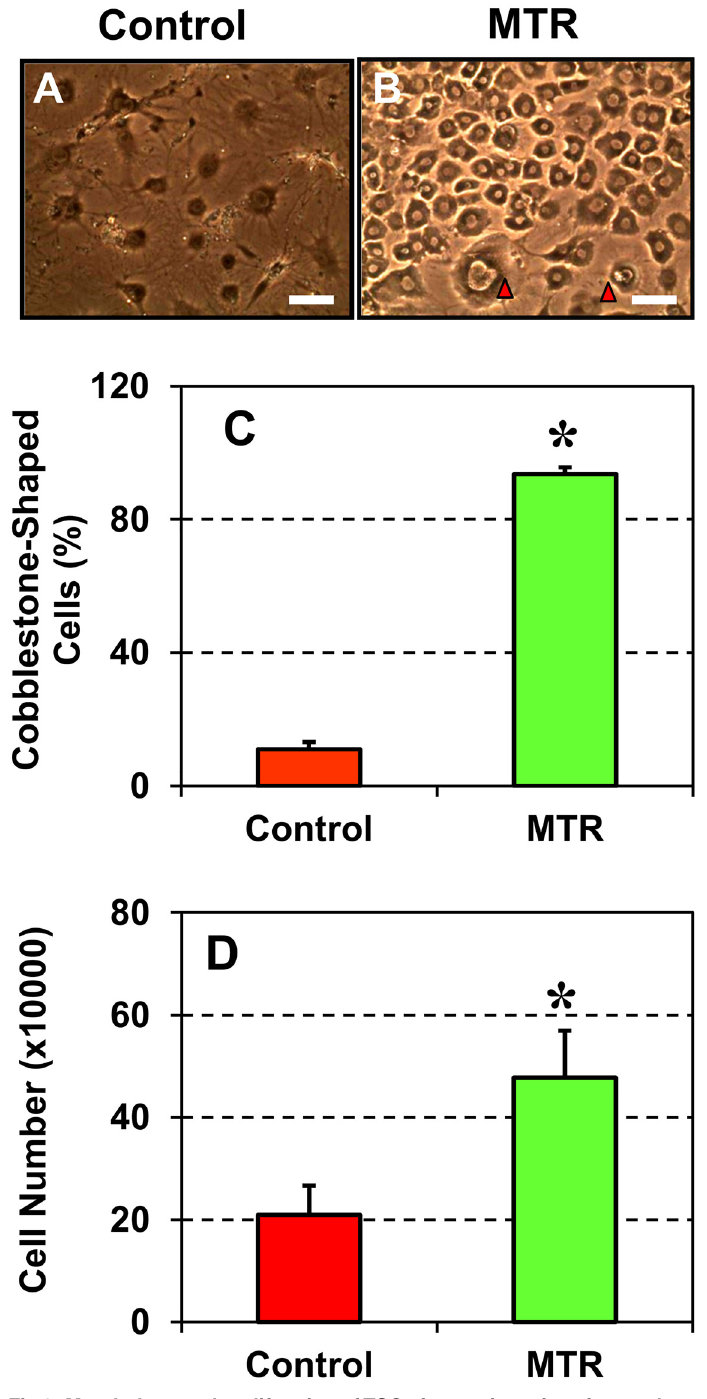
Fig 6. Morphology and proliferation of TSCs from aging mice after moderate treadmill running (MTR). A. Control mice without MTR. B . Mice after MTR, C. Semi-quantitation of the number of cobblestone-shaped TSCs. D. TSC proliferation, measured as PDT, from mice in the control and MTR groups. Aging TSCs in the control group were large and round, a typical phenotype of senescent cells, but after MTR most cells exhibited a cobblestone shape (arrows point to the two remaining large TSCs as in the control group), which also proliferated at a higher rate. Data are mean ± SD, and * P < 0.05, in comparison with data from the control group. Bar — 100 μ